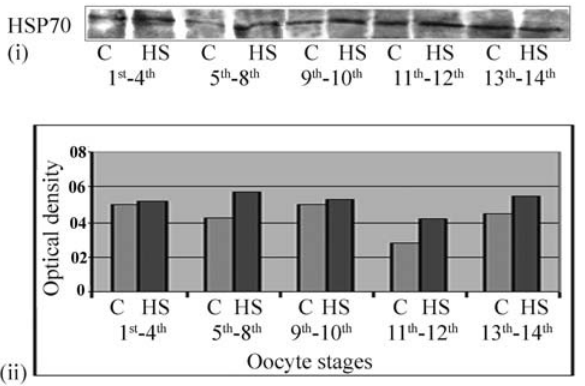
Figure 3C - (i). Western blot showing HSP70 expression pattern during the 1 st -4th, 5 th -8 th , 9 th -10 th , 11 th -12 th and 13 th -14 th stages of oocyte develop- ment in M. domestica at the control (C, 25 °C) and heat shock (HS, 42 °C) temperatures . (ii) Histogram showing densitometric optical density (OD) measurement of band intensity in the corresponding western blot lanes shown in (i) above.